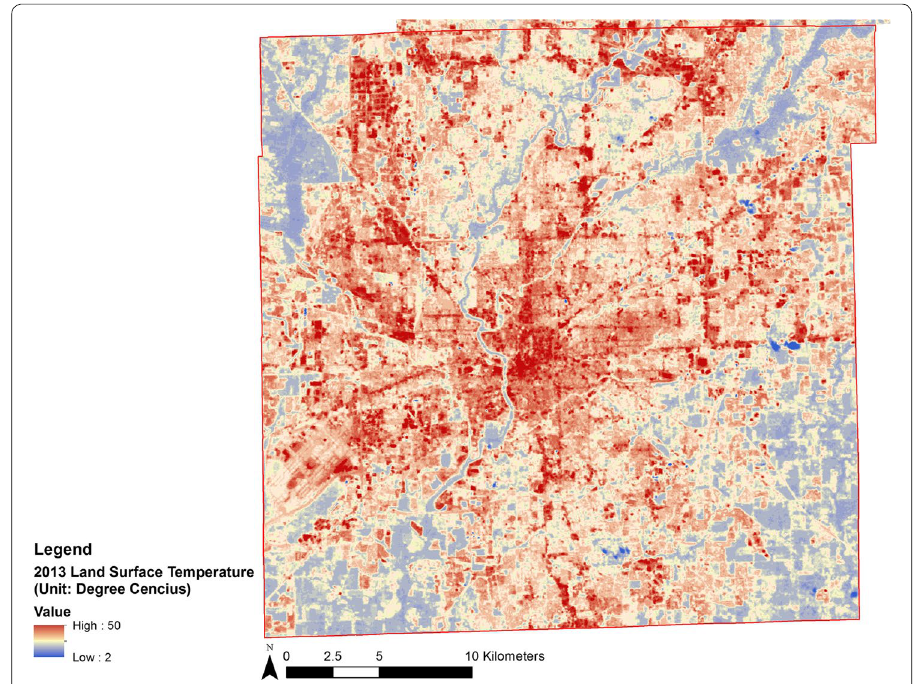
Fig. 2 Spatial distribution of summertime land surface temperature of study area, July